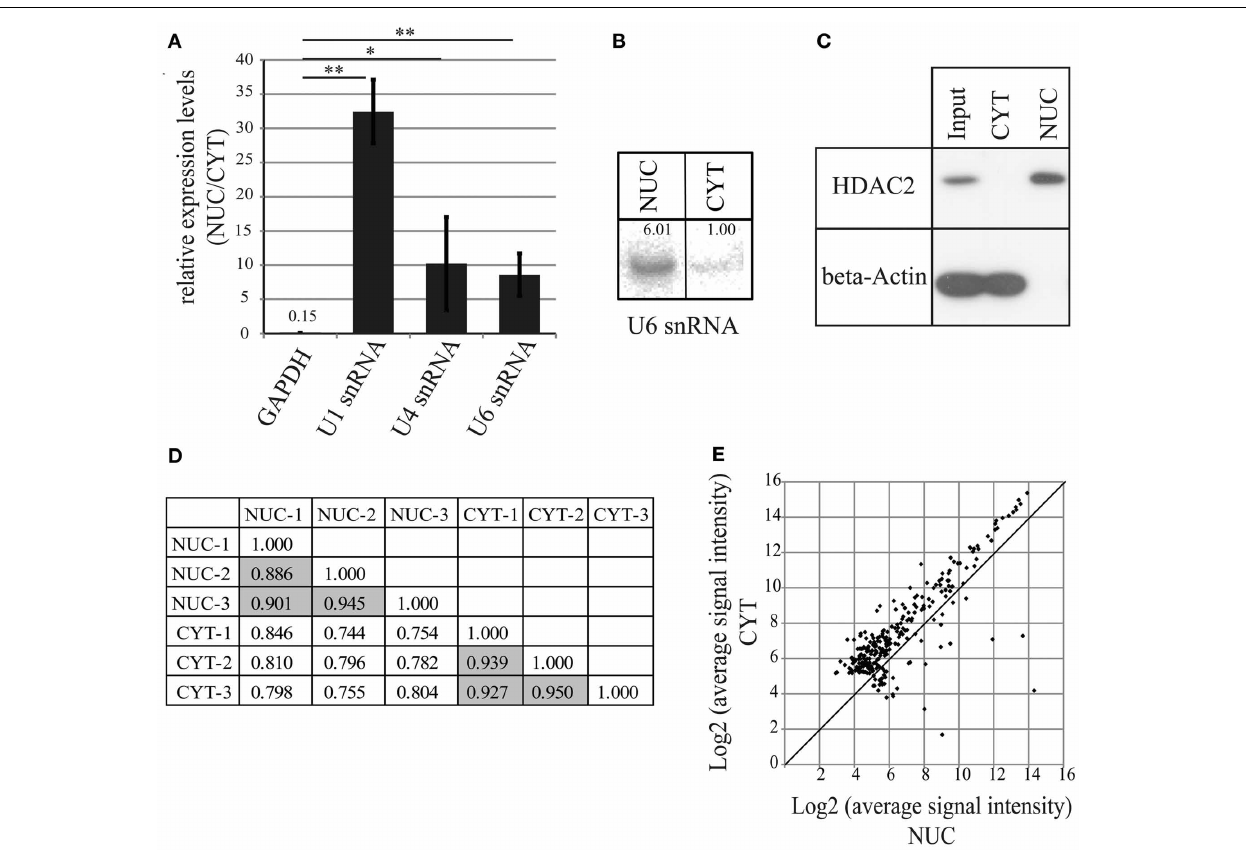
FIGURE 1 | MiRNA profiling by microarray after nucleo-cytoplasmic fractionation of neurons. (A) qRT-PCR analysis of marker genes to validate the fractionation protocol. The fold enrichment (y-axis) of marker genes in the nucleus was calculated by the 2 − dCt [2 − ( NUC Ct − CYT Ct ) ] method. Bar plots show mean ± standard deviation ( SD ; n = 3). Statistical significance was determined using Student’s t -test with Bonferroni correction ( ∗ p < 0 . 05; ∗∗ p < 0 . 01). (B) Northern blot analysis of the nuclear marker U6 snRNA in nuclear and cytoplasmic fractions. Intensity of the signal was quantified using ImageJ. (C) Detection of nuclear (HDAC2, histone deacetylase 2) and cytoplasmic (beta-Actin) marker proteins in the